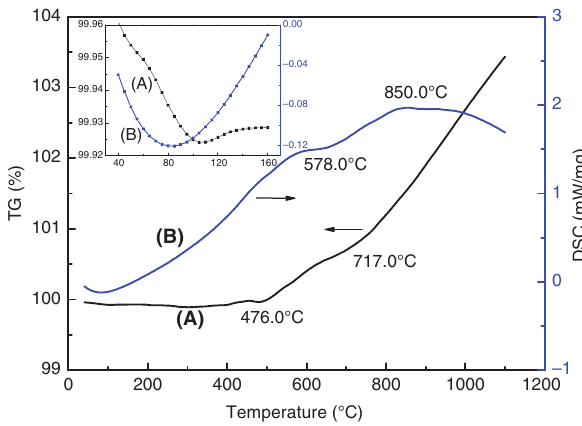
Figure 4: Thermogravimetric/differential scanning calorimetry (TG/DSC) curves of high titanium slag. (A) TG; (B)